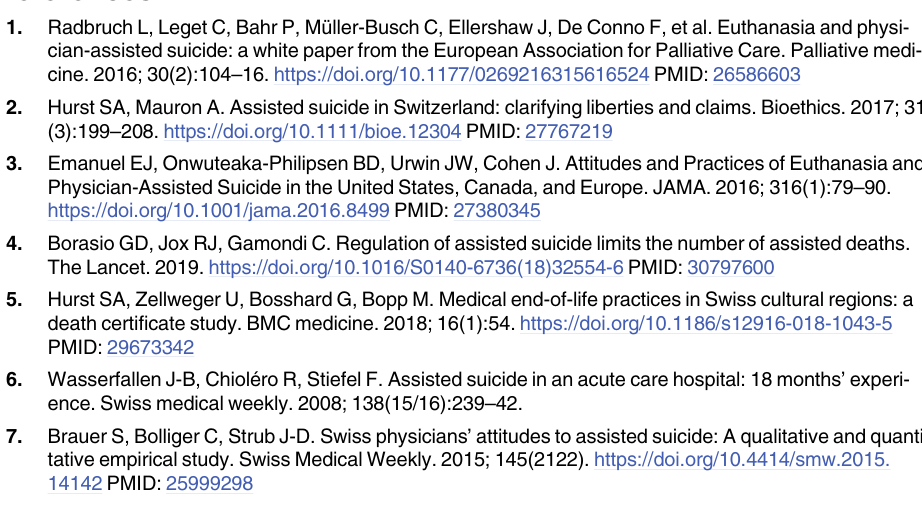
S2 Table. Factors associated with positive general attitude toward the assisted suicide for oneself (univariate and multivariable analyses). S3 Table. Factors associated with a positive general attitude toward the participation of health care professionals in assisted suicide (univariate and multivariable analyses). S4 Table. Professions’ distribution of the participants that reported experience with requests for suicide assistance in the context of their professional activity in the hospital. (n = 1’850 due to missing data for some sociodemographic